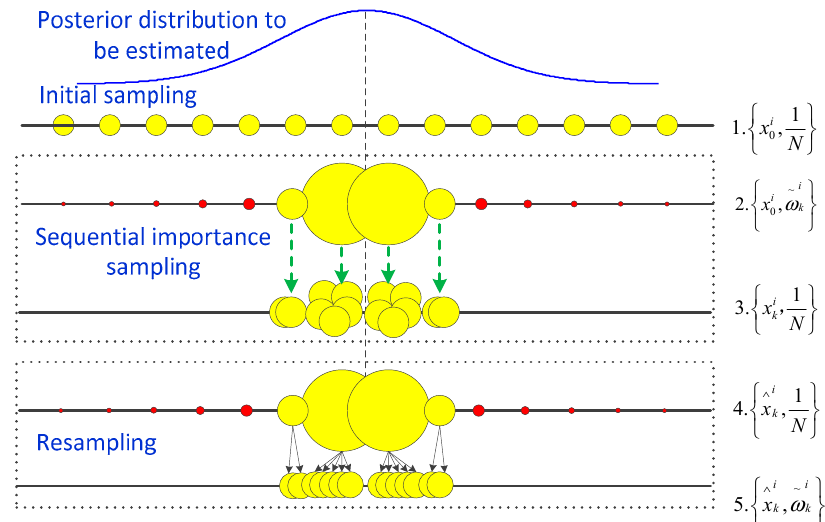
Figure 1. Schematic diagram of particle filter frame (PFF).